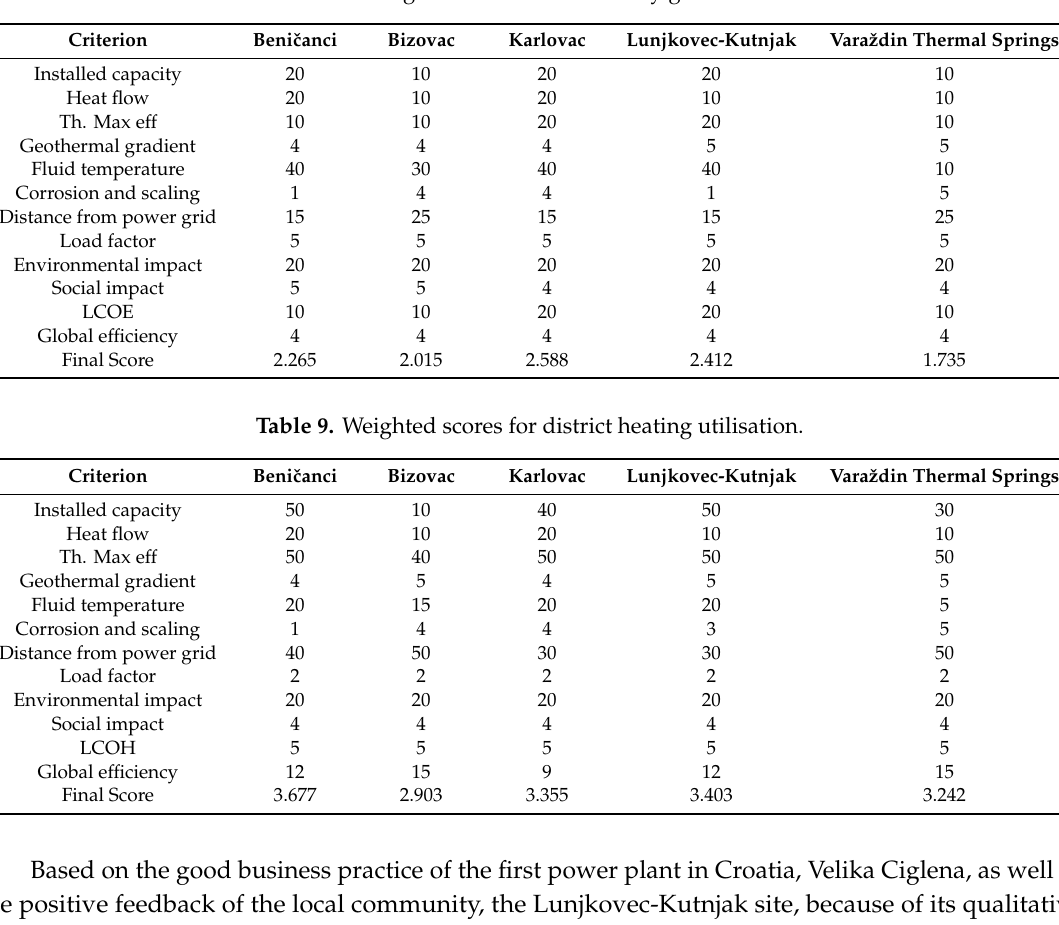
Table 8. Weighted scores for electricity generation.